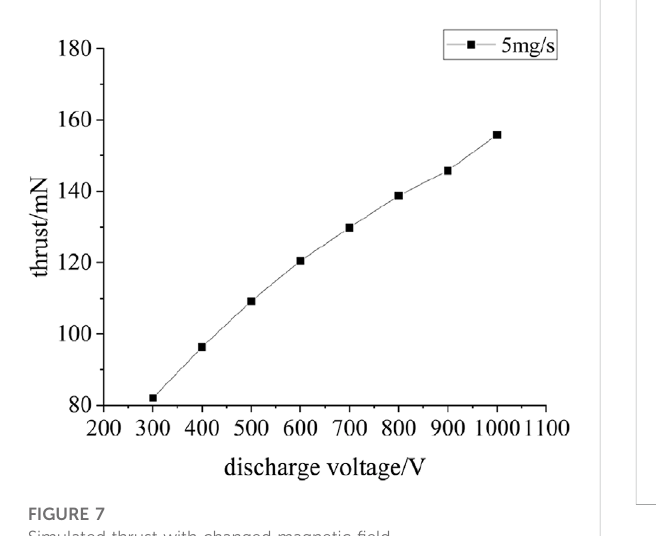
FIGURE 7 Simulated thrust with changed magnetic fi eld.